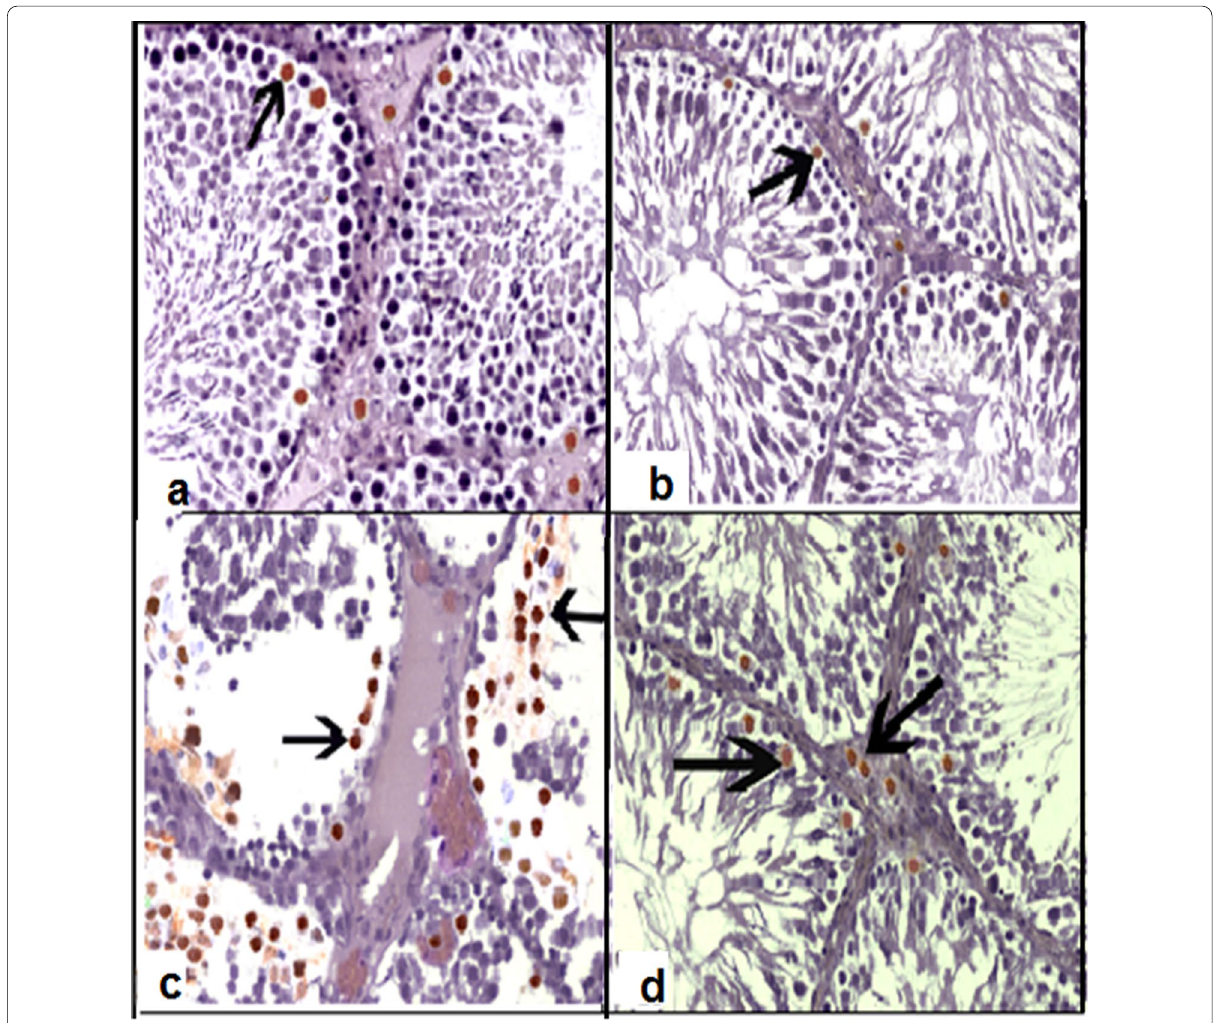
Fig. 2 a Light micrographs (LM) of a transverse section of the control group stained with P53‑ir showed a faint positive affinity for P53 (arrows) (P53 X400). b Light micrographs (LM) of a transverse section of the costus second group stained with P53‑it showed a faint positive affinity for P53 (arrows) (P53 X400). c Light micrographs (LM) of a transverse section of testis of rat (third group) stained with P53‑ir showed a strongly positive affinity for